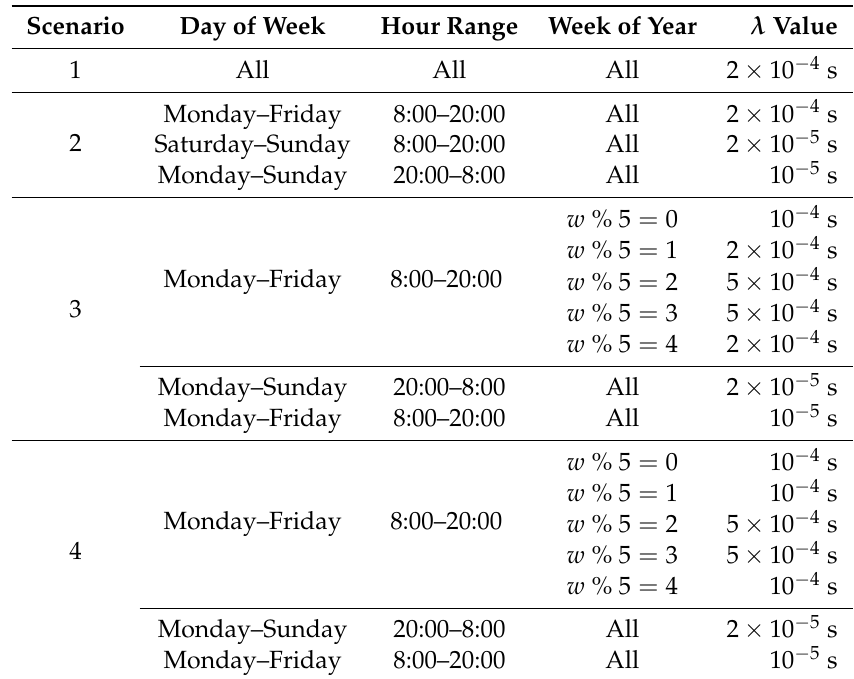
Table 1. Poisson process of job arrivals in each